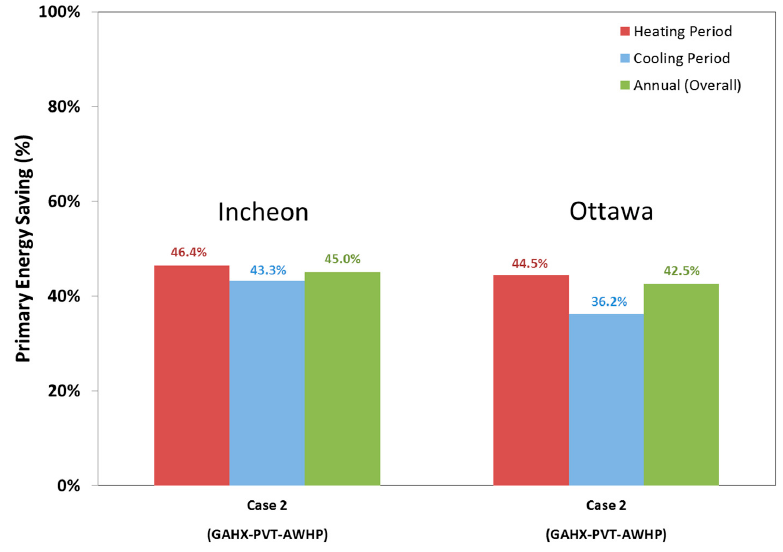
Figure 8. Overall primary energy saving of GAHX ‐ PVT ‐ AWHP trigeneration system.